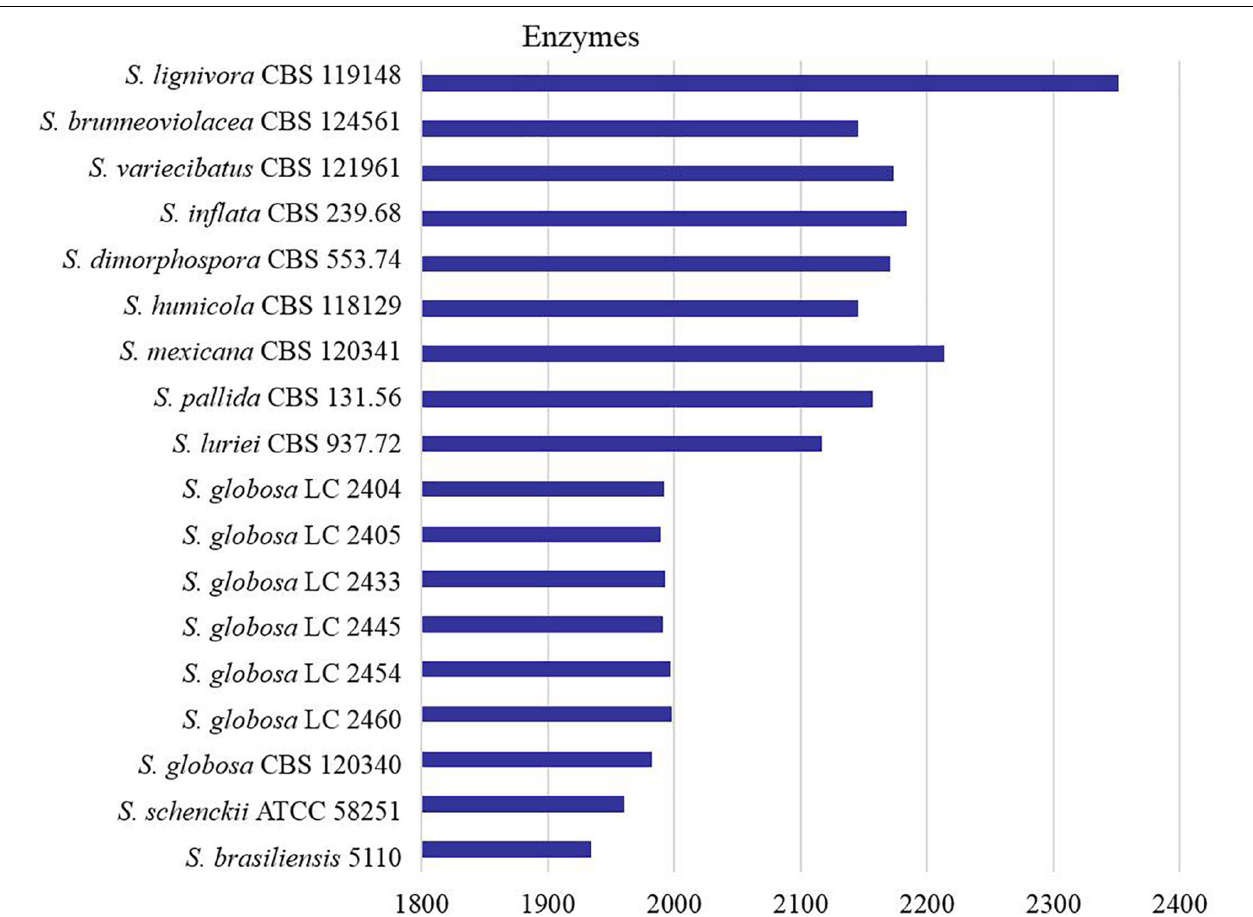
FIGURE 2 | Counts of the enzymes encoded by genes in Sporothrix. Enzyme genes of four main clinical species ( S. brasiliensis , S. schenckii , S. globosa and S. luriei ) were less than most of environmental and other clinical species.